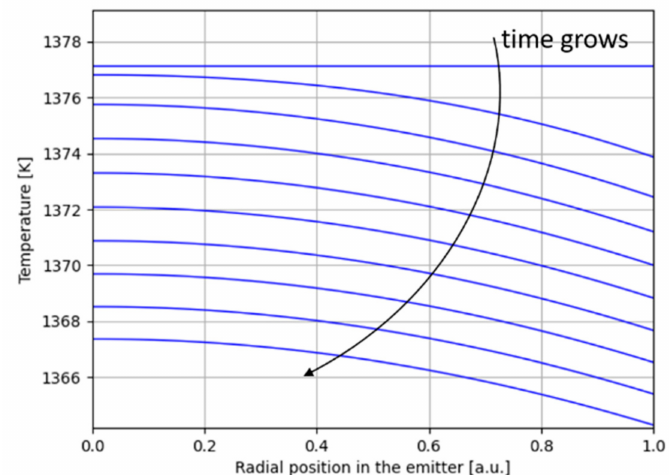
Figure 11. Radial distribution of the temperature computed in the simplified problem, as a function of the normalized radial position inside the emitter (the value 0 corresponds to the inner emitter surface, while value 1 corresponds to the outer surface, from which electrons are emitted).